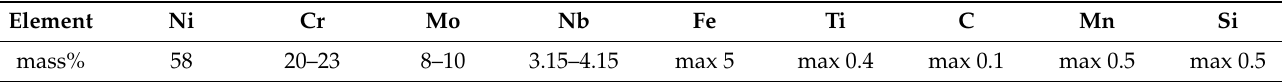
Table 1. Chemical composition of Inconel 625